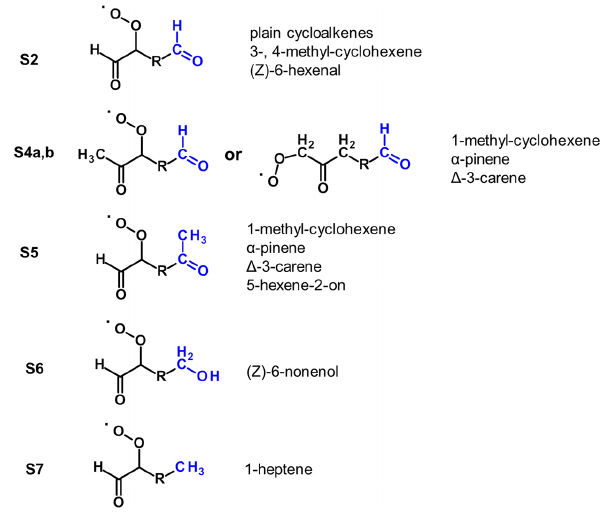
Figure 3. Peroxy radicals of the investigated VOC as expected from the vinylhydroperoxide path. Position of the peroxy group and func- tionality at the ω -terminal end.